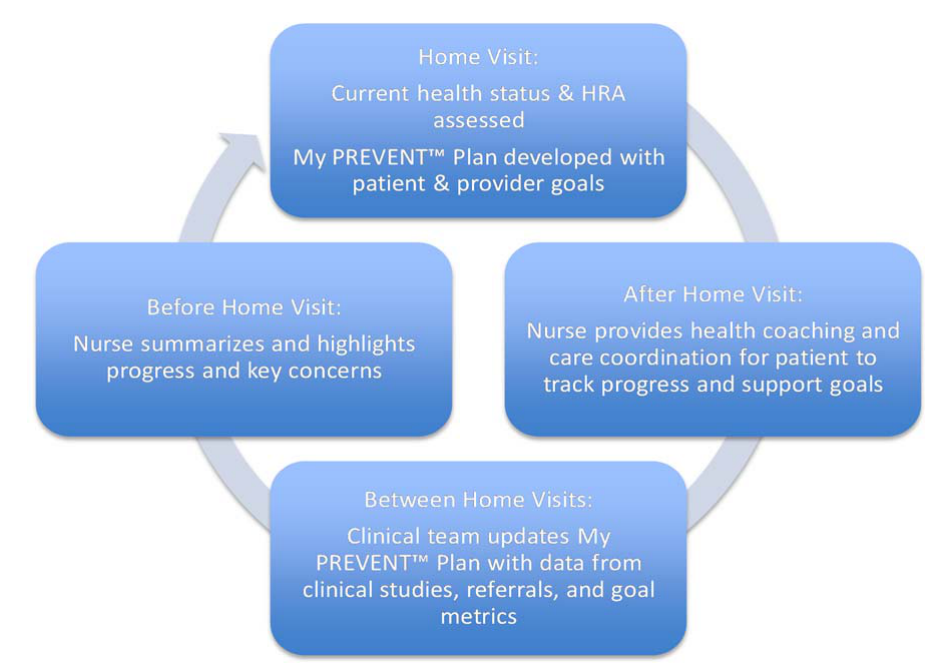
Figure 1. The cyclical work flow from initial Just for Us (JFU) home visit through activities after the visit to preparation for the next home